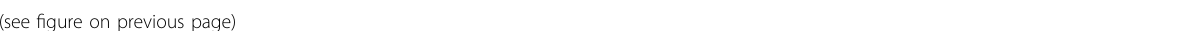
indicated), or a non-targeting control (NTC), using KD of MLL and MEN1 , as positive controls, which are essential genes for AML cell proliferation. All bar charts show mean± s.e.m. A Resoru fi n signal after 4 days of individual KDM4 family member KD relative to NTC control cells ( n = 3); * p < 0.01